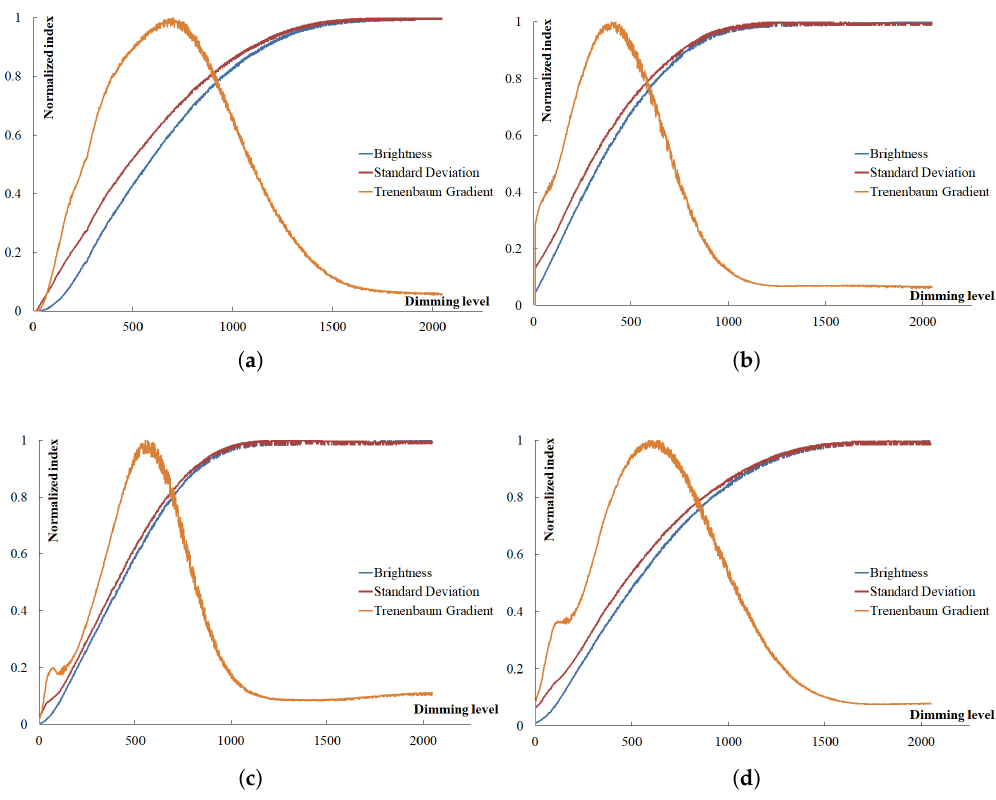
Figure 3. Response of normalized image index by dimming level increment ( a ) red ( b ) green ( c ) blue and ( d )